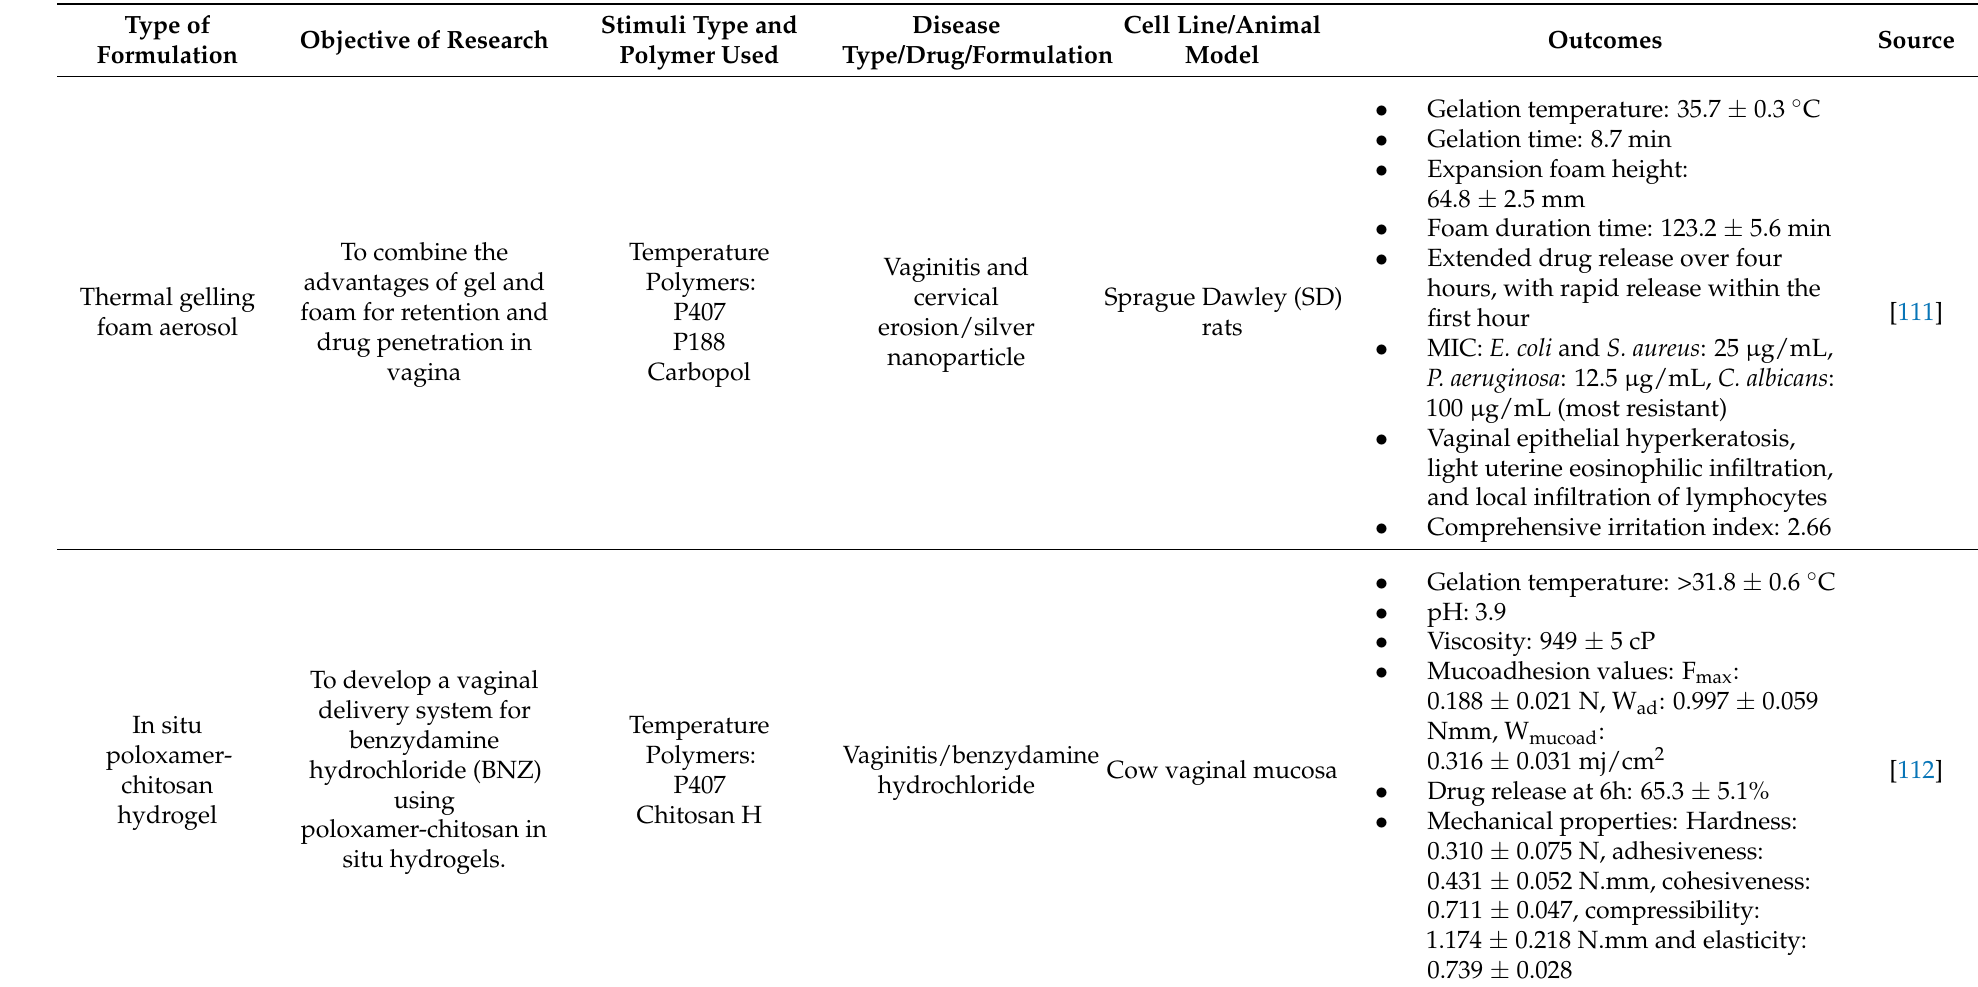
Table 3. Thermo-responsive systems for vaginal drug